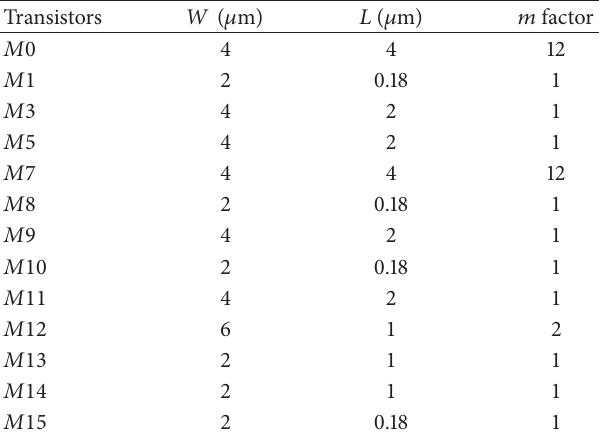
Table 1: Transistor dimensions used in this proposed